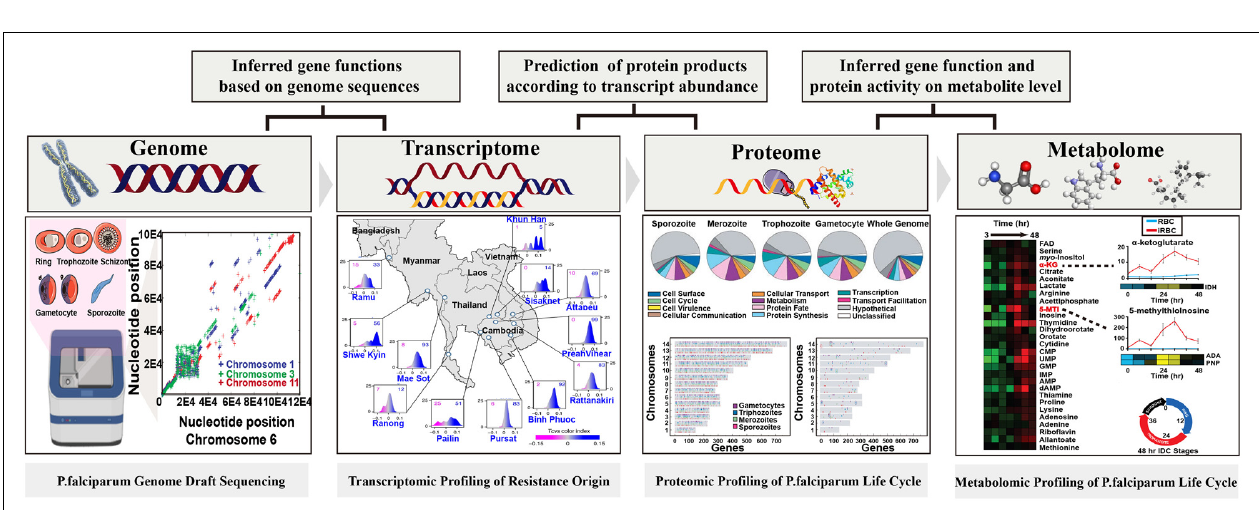
FIGURE 2 | Overview of the relationship between each omics approach and ground-breaking applications in Plasmodium spp. Figures of significant achievements are adapted from Gardner et al. (2002), Florens et al. (2002), Olszewski et al. (2009), Zhu et al. (2018) and the copyright of each figure has been achieved.